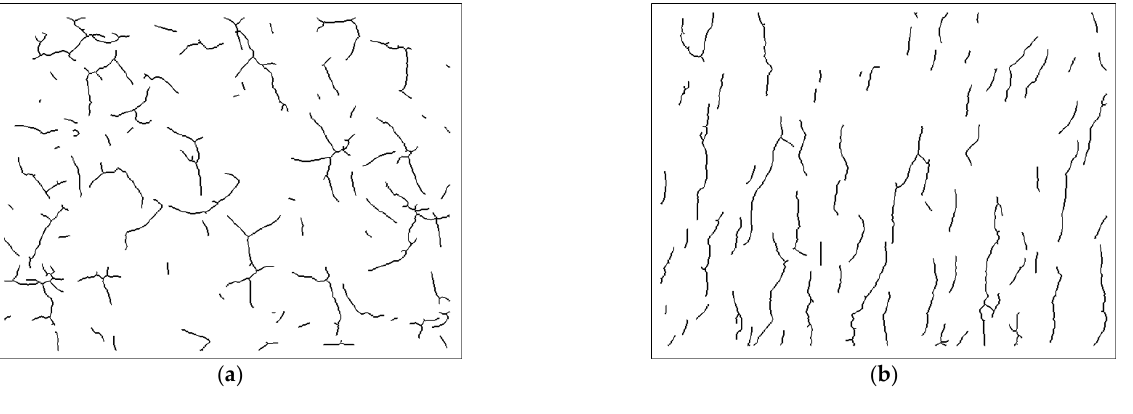
Figure 11. Image processing of subsurface crack morphology under two grinding wheels; the subsurface cracks were black, and the surrounding area was white: ( a ) is the result after processing in Figure 7c, and ( b ) is the result after processing in Figure 8c.